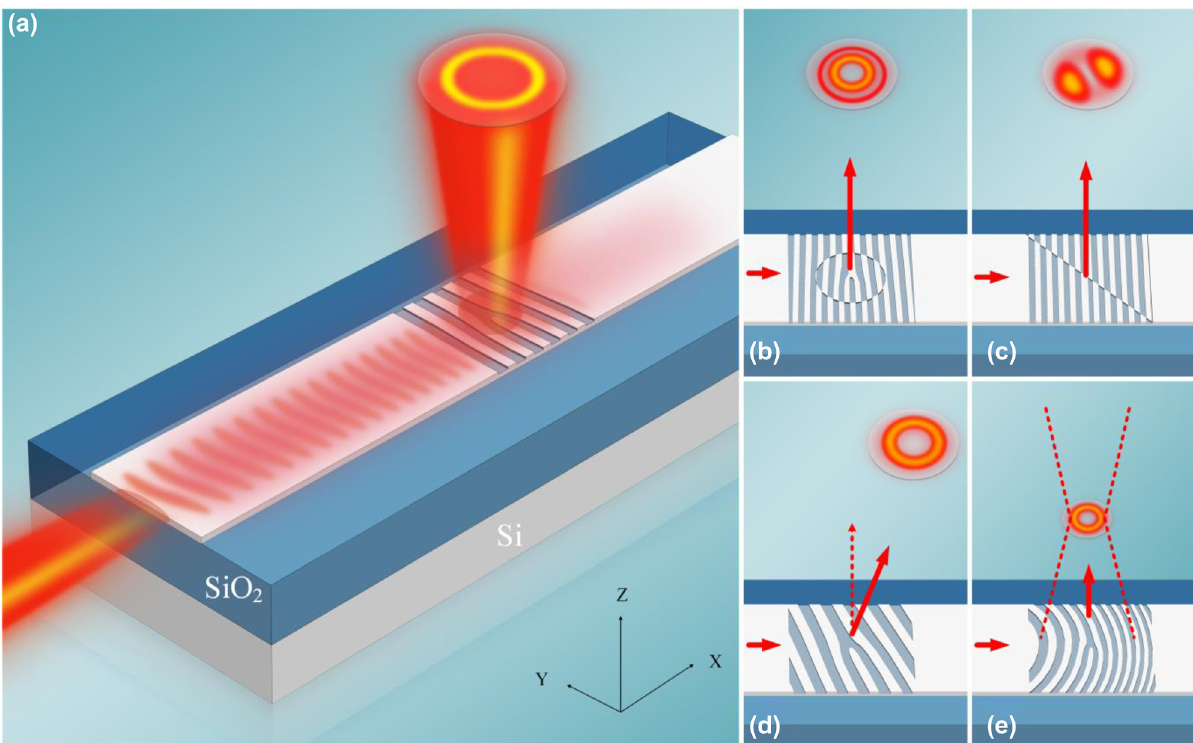
Figure 1: Subwavelength holographic surface gratings. (a) Schematic of the photonic integrated vortex beam generator based on holographic subwavelength fork grating. (b–e) Different holographic subwavelength fork grating structures for the phase-structured beam generation of LG and LP modes, and vortex beams manipulation of angled emission and